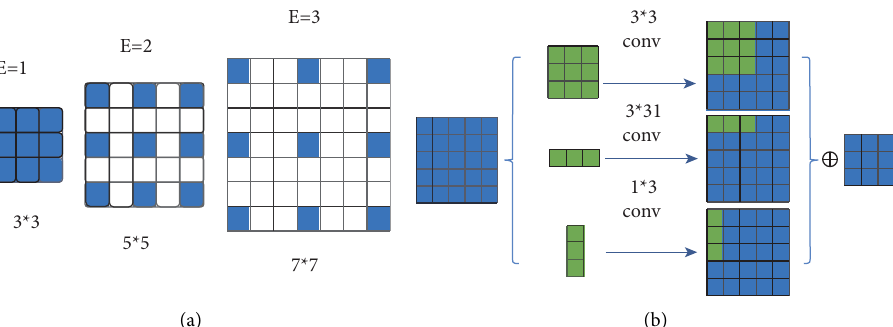
Figure 4: Atrous convolution and asymmetric convolution. (a) Dilated convolution and (b) asymmetric